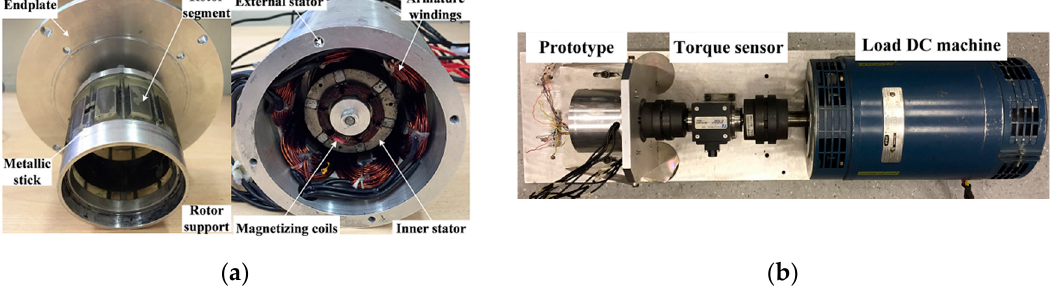
Figure 12. The manufactured prototype of the 6-slot slot/11-pole PS-SF-HMMM. ( a ) Prototype; ( b ) Test rig.